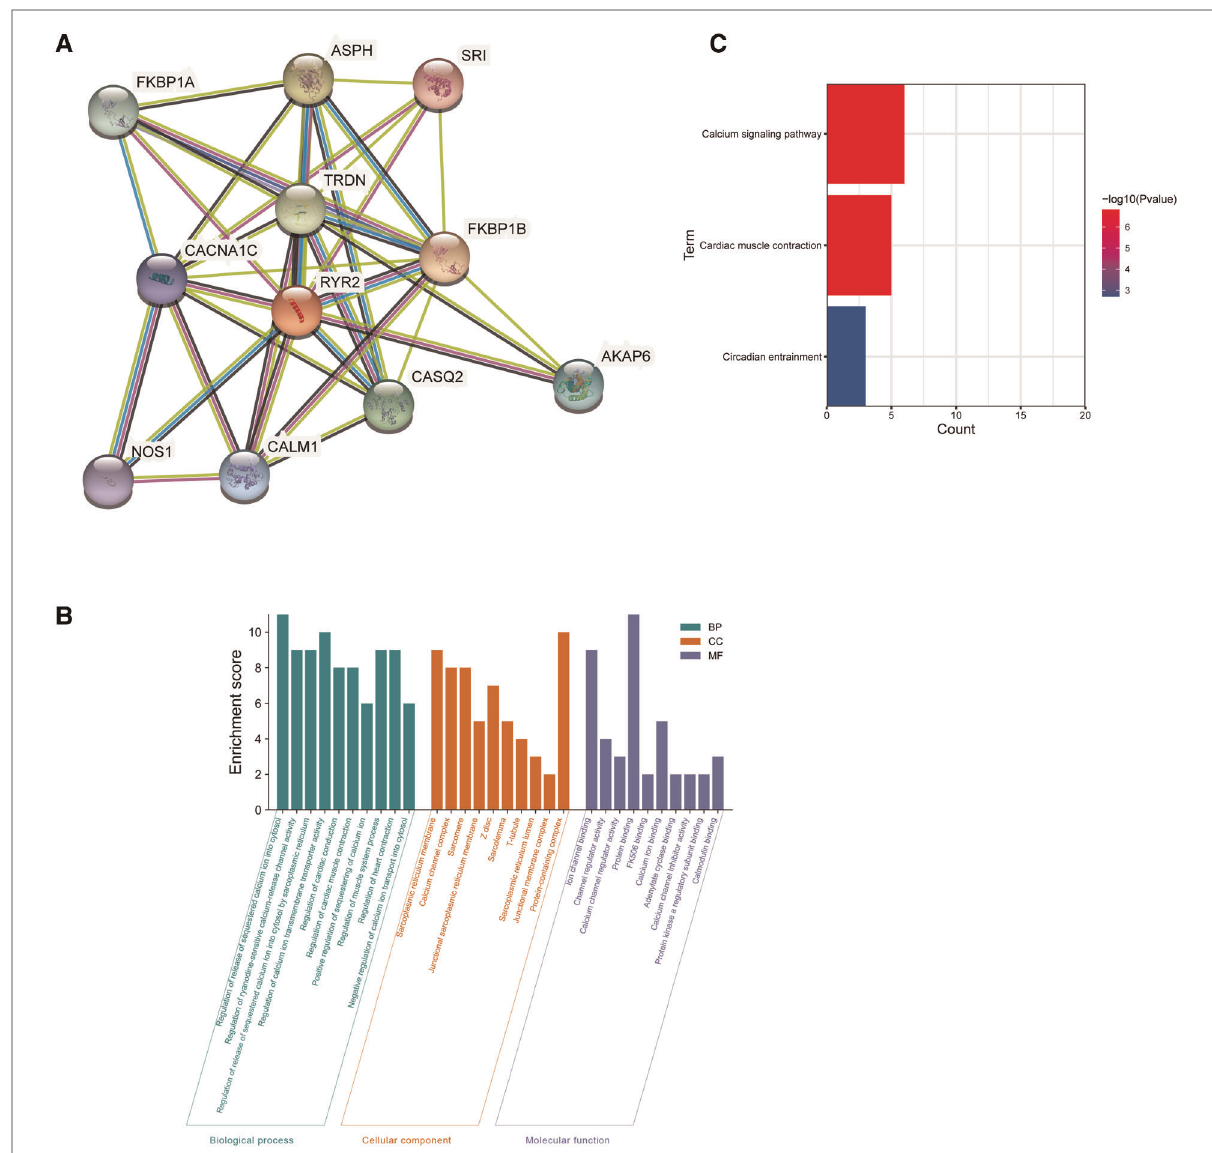
FIGURE 5 Go and KEGG enrichment analysis of the PPI network. ( A ) PPI network analysis of interacting genes with RYR2. Circles are used to represent nodes, and lines are used to represent edges. ( B ) GO terms of target genes. ( C ) KEGG